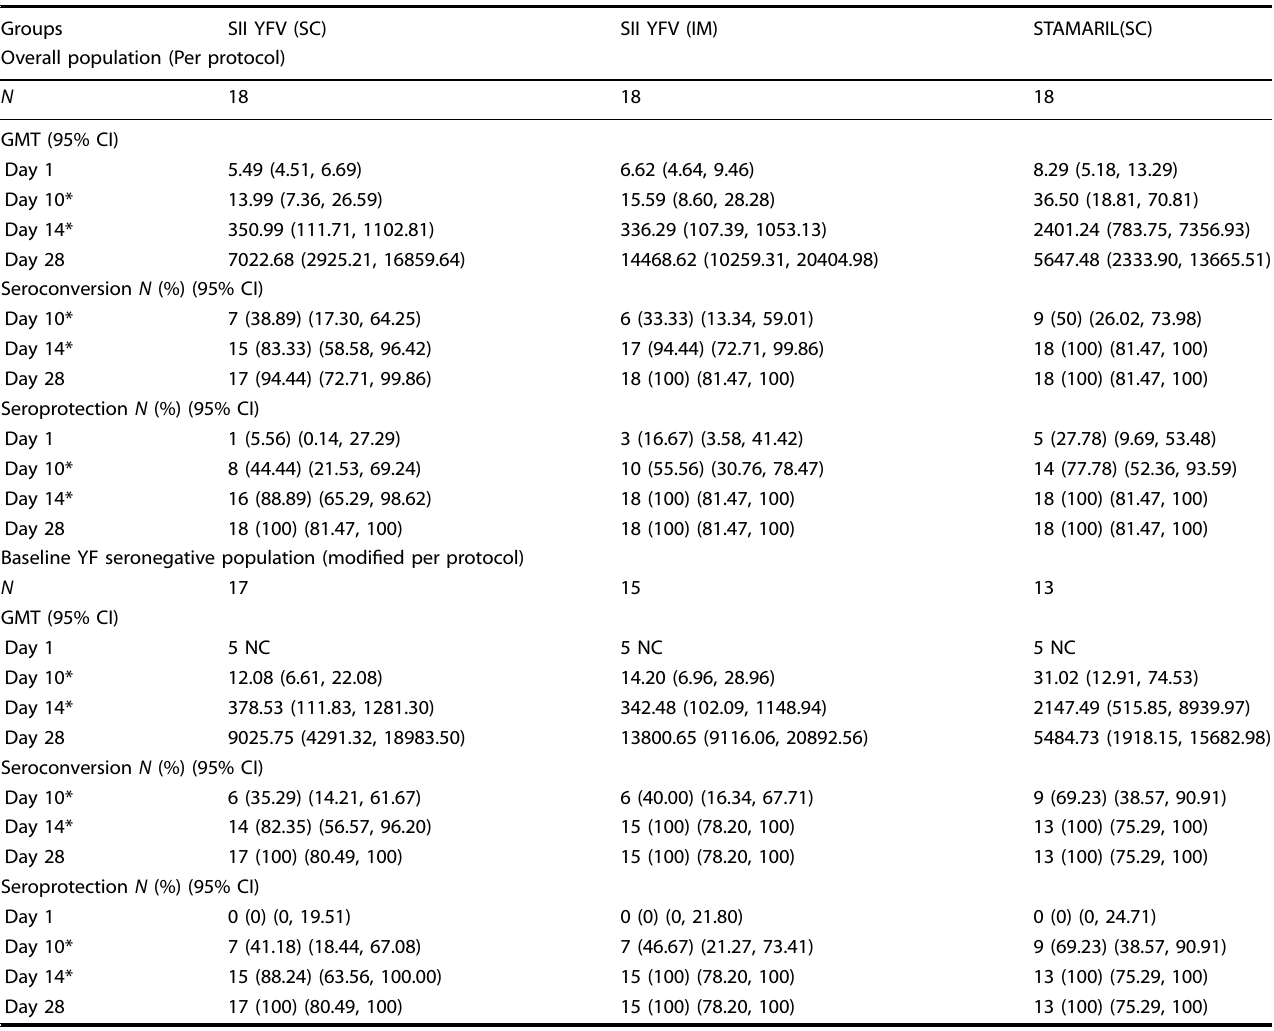
Table 3. Immunogenicity results of participants on Days 1, 10, 14 and 28 of vaccination. Groups SII YFV (SC) SII YFV (IM)